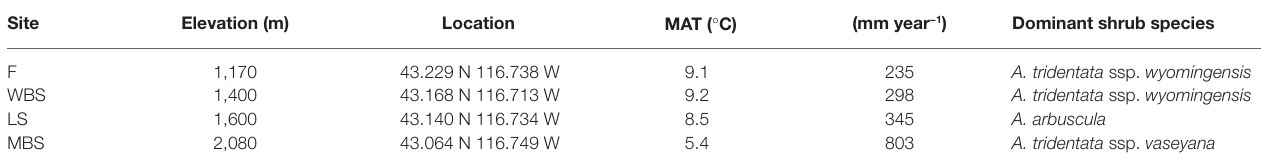
TABLE 1 | Description of each sampling site according to their elevation, GPS location (latitude and longitude), mean annual temperature (MAT), mean annual precipitation (MAP), and dominant sagebrush vegetation.